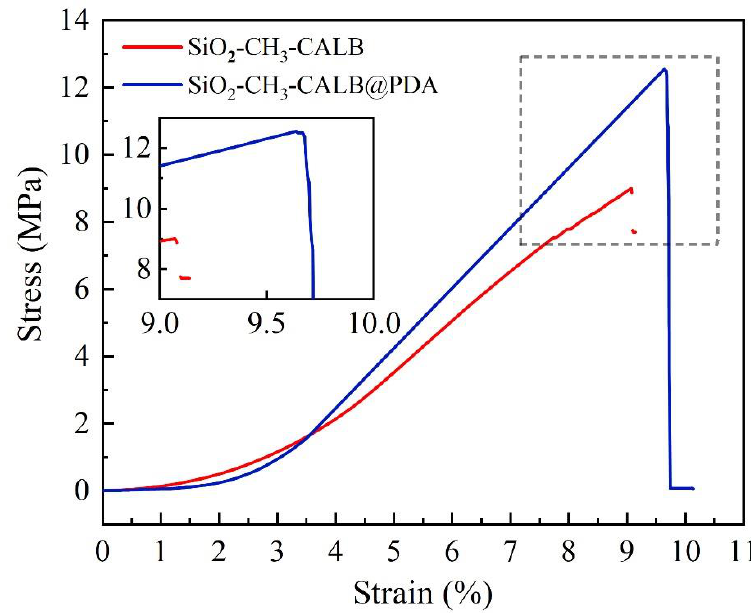
Figure 6. Stress–strain curves of SiO 2 –CH 3 –CALB and SiO 2 –CH 3 –CALB@PDA.